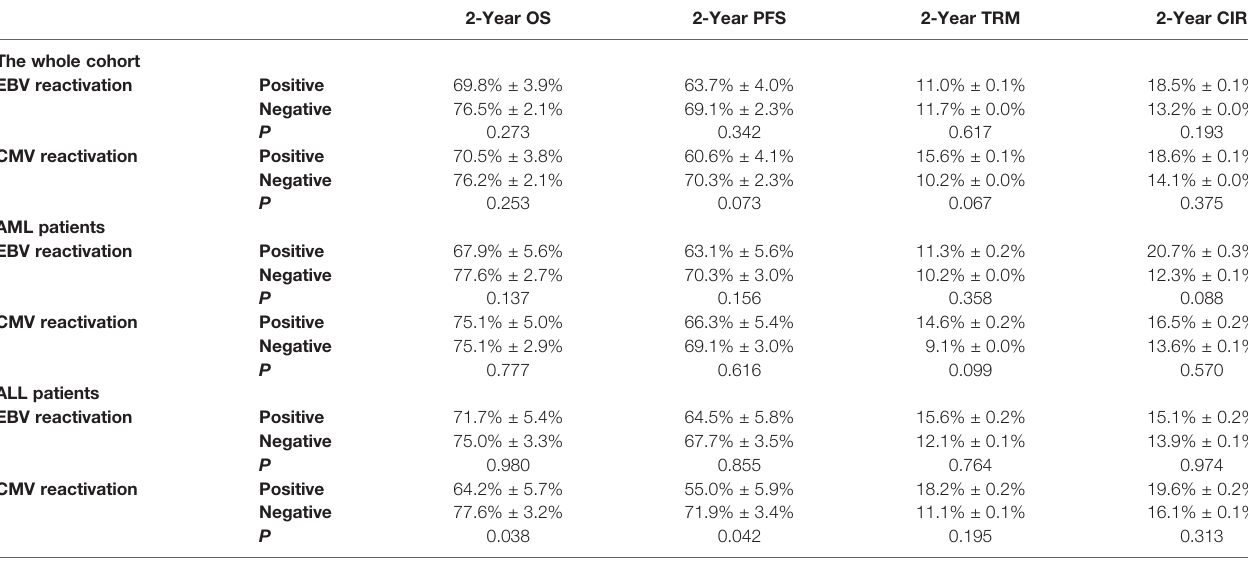
TABLE 3 | Comparisons of transplant outcomes of patients with or without viral reactivations